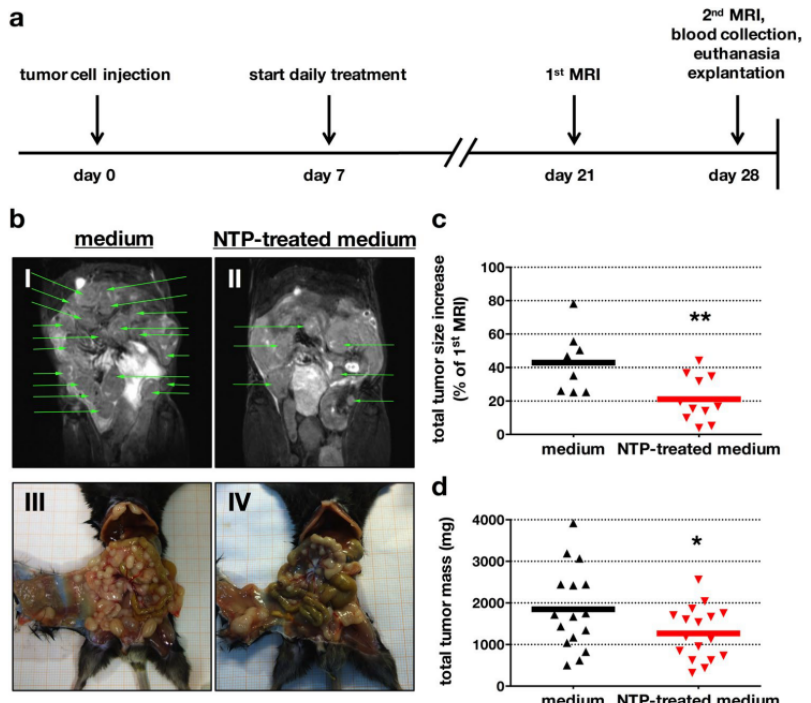
Figure 15. Efficacy of the repeated intraperitoneal administration ( a ) of PTS (RPMI medium without supplements) against syngeneic, orthotopic, disseminated pancreatic cancer analyzed using MR-Imaging (I–II) and macroscopic imaging (III–IV) ( b ) and its quantification ( c ) as well the absolute tumor weights ( d ). Each triangle represents one mouse. * p < 0.05, ** p < 0.01. Reprinted with permission from [86] . Copyright 2017 Springer Nature.